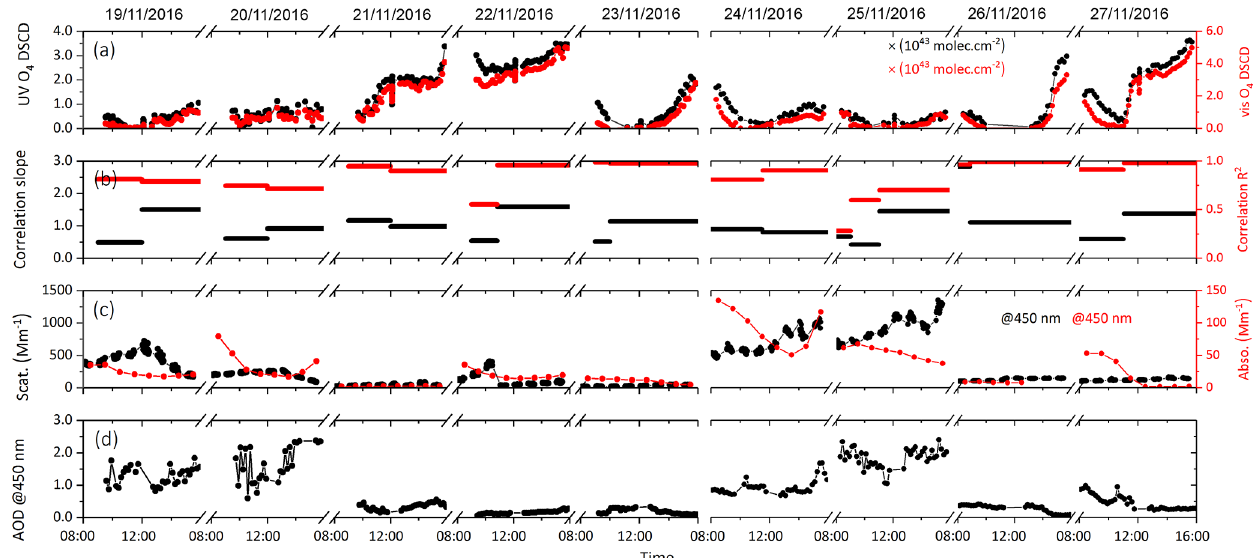
Figure 7. Time series of O 4 absorptions and aerosol optical properties at Gucheng, Hebei, from 19 to 27 November 2016: (a) UV and visible O 4 DSCDs, (b) correlation slopes and R 2 between O 4 DSCDs at 360.8 and 477.1nm, (c) σ sca and σ abs at 450nm, (d) AOD at 450nm retrieved by